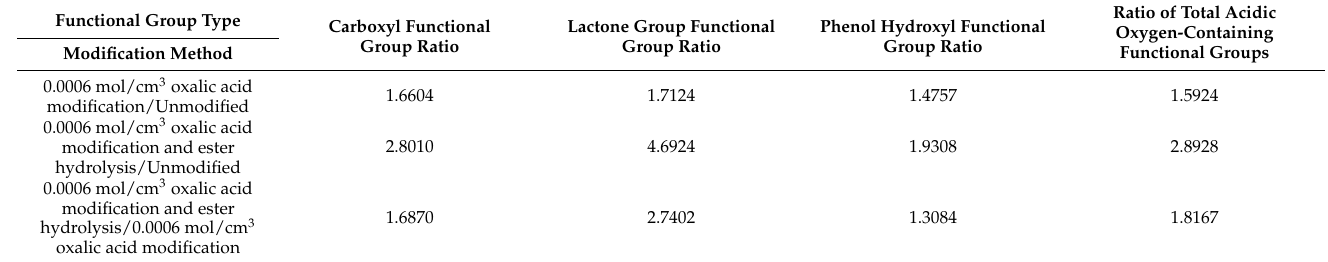
Table 2. Boehm titration test ratio of functional groups before and after activated carbon